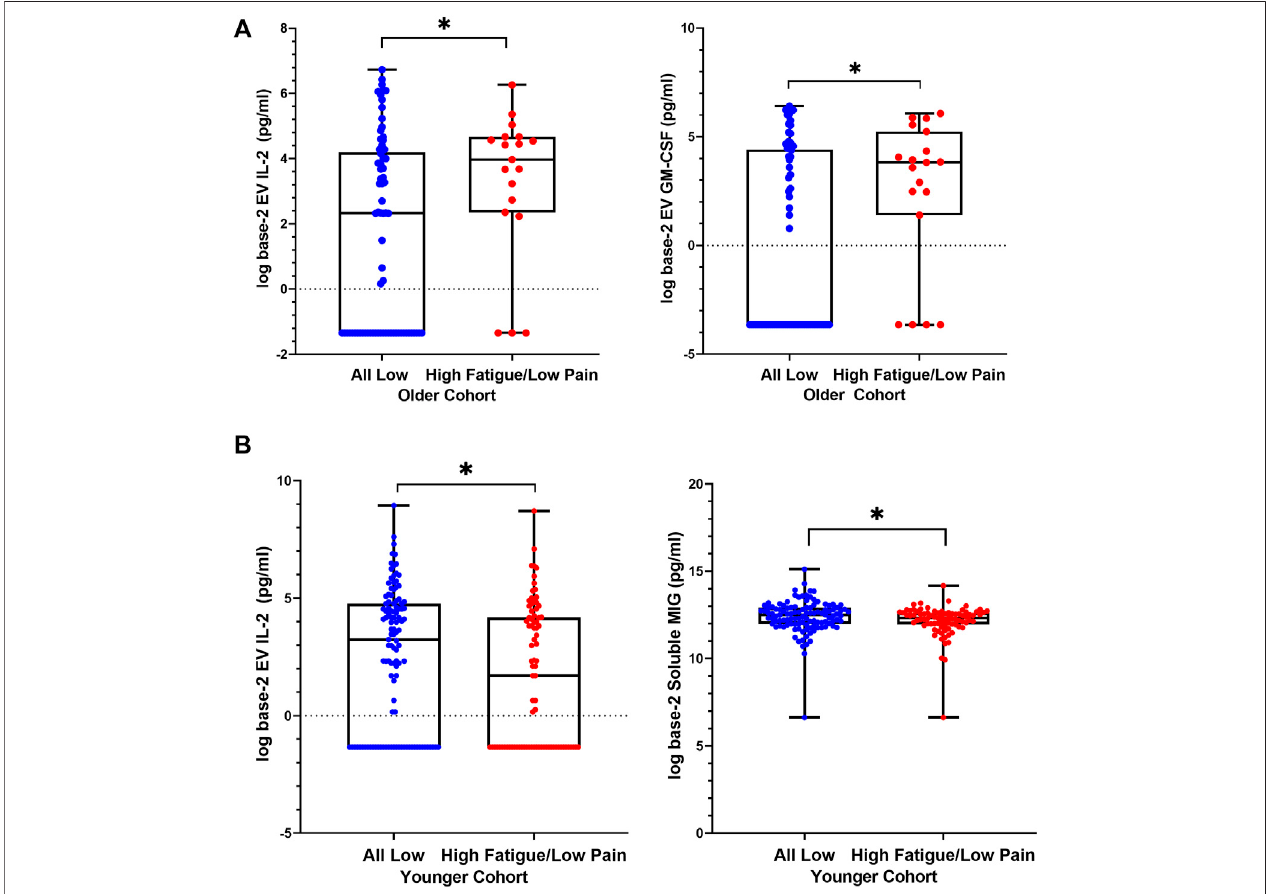
FIGURE 2 | Differences in levels of extracellular vesicle-associated cytokines between High Fatigue/Low Pain versus All Low classes. Distributions are represented using boxplots, showing median, IQR, and maximum and minimum. (A) In older cohort, Mann-Whitney U tests comparing the two classes showed signi fi cantly higher EV IL-2 ( p = 0.032) levels in the High Fatigue/Low Pain class (median = 3.97, IQR 2.3 – 4.7) compared to the All Low class (median = 2.3, IQR − 1.3 – 4.2). Concentrations of EV GM-CSF ( p = 0.025) were signi fi cantly elevated in the High Fatigue/Low Pain class (median = 3.8, IQR 1.4 – 5.2) compared to the All Low class (median = − 3.6, IQR − 3.6 – 4.4). (B) In younger cohort, Mann-Whitney U test comparing the two classes showed signi fi cantly higher EV IL-2 ( p = 0.040) levels in the All Low class (median = 3.2, IQR − 1.3 – 4.7) compared to the High Fatigue/Low Pain class (median = 1.6, IQR − 1.3 – 4.2). Concentrations of soluble MIG ( p = 0.043) were signi fi cantly elevated in the All Low class (median = 12.5, IQR 11.9 – 12.9) compared to the High Fatigue Low Pain class (median = 12.3, IQR 11.9 – 12.6). Abbreviations: EV = extracellular vesicle, GM-CSF = granulocyte-macrophage colony-stimulating factor, IL = interleukin, MIG = monokine induced by IFN- γ